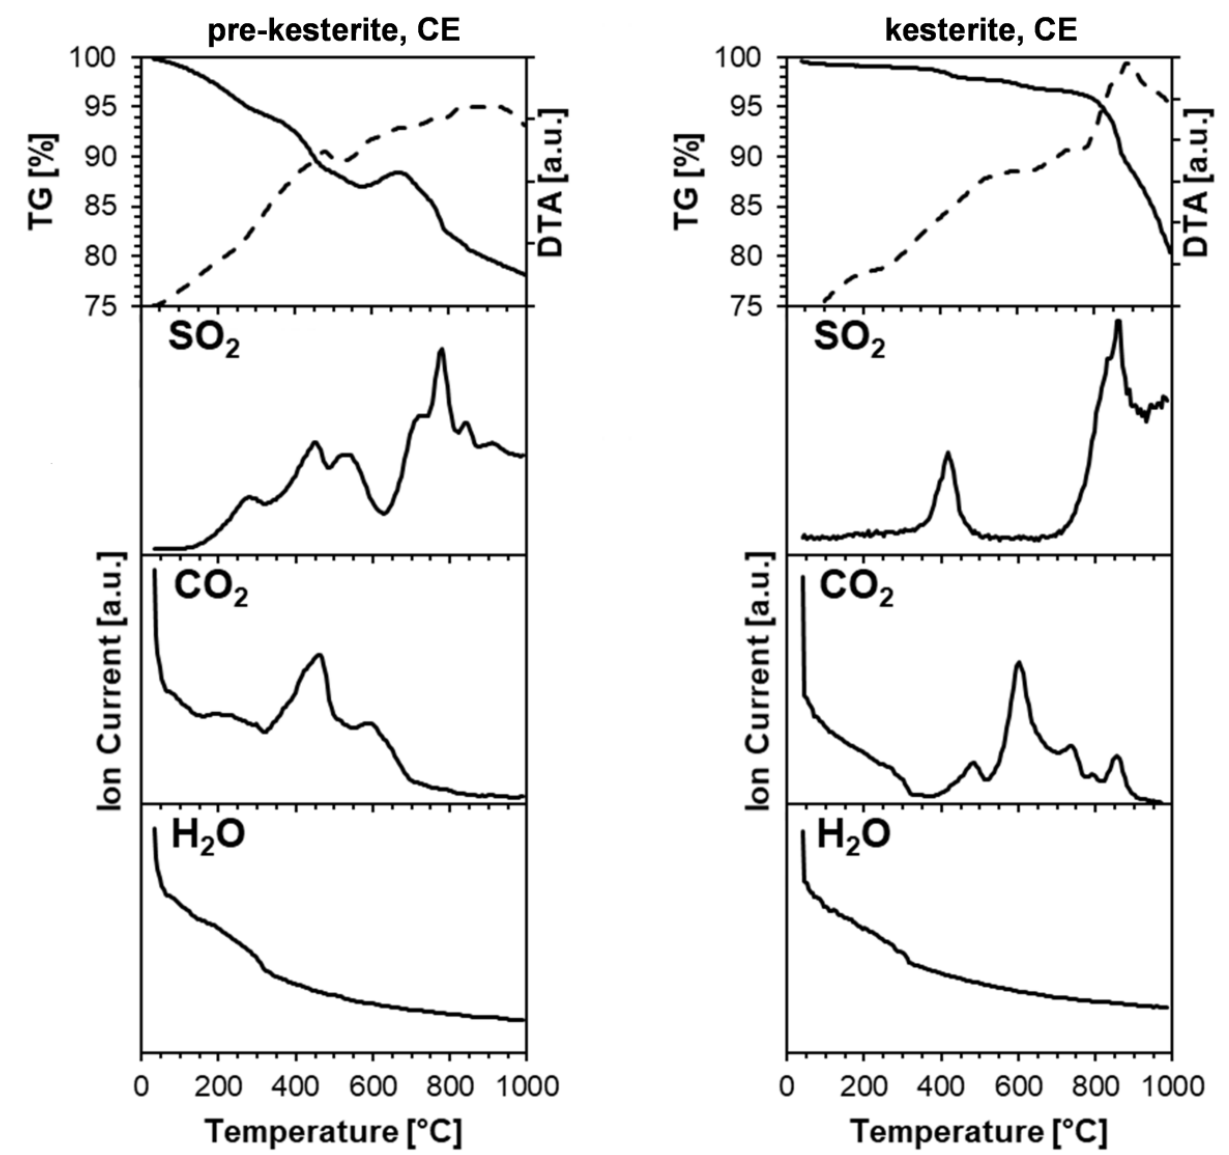
Figure 7. TGA-DTA/MS data up to 1000 ◦ C for the nanopowders of prekesterite ( left column) and kesterite ( right column) from the CE system. In the top row, the solid-line curve depicts thermogravimetric TGA changes, and the dashed-line curve shows thermal DTA changes. In the rows below, the evolution of the selected gases containing oxygen on heating is displayed (consecutively, from top to bottom, SO 2 , CO 2 , and H 2